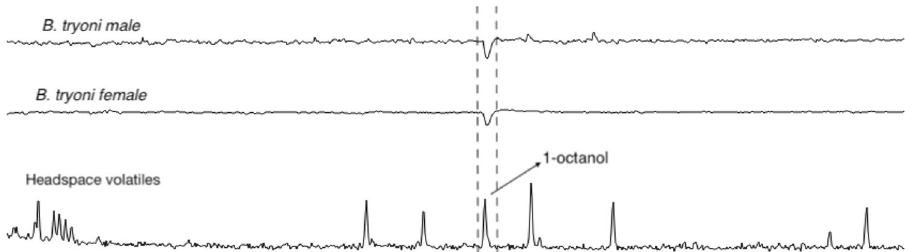
Figure 2. Representative GC-EAD recording of male and female B. tryoni response to headspace volatiles of O. smaragdina . In both male and female flies the FID peak marked as ‘1-octanol’ was the only compound that elicited consistent